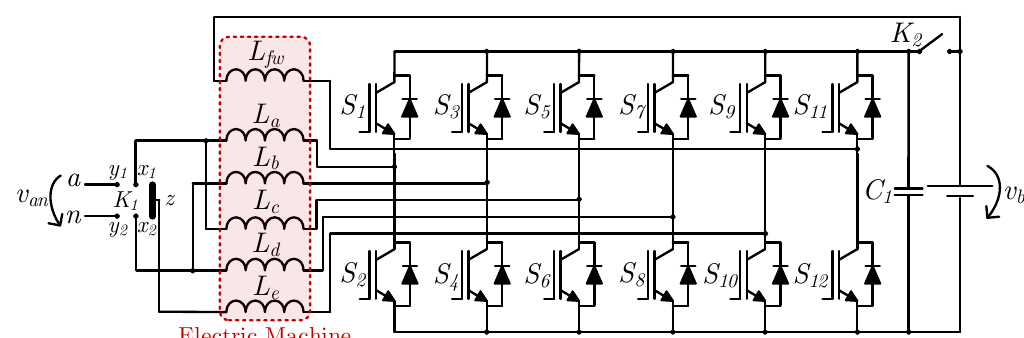
Figure 20. EV IBC proposed by M. Tong et al. in 2020 [44].